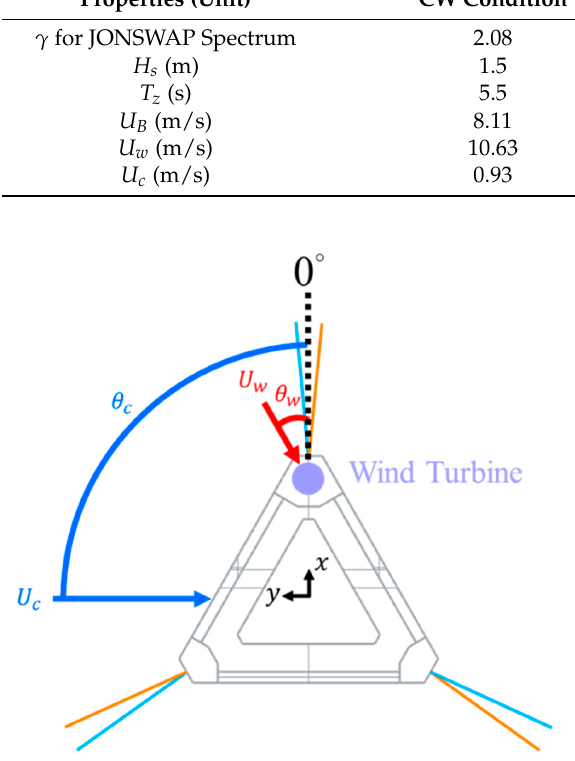
Figure 10. Definition of wind, wave, and current